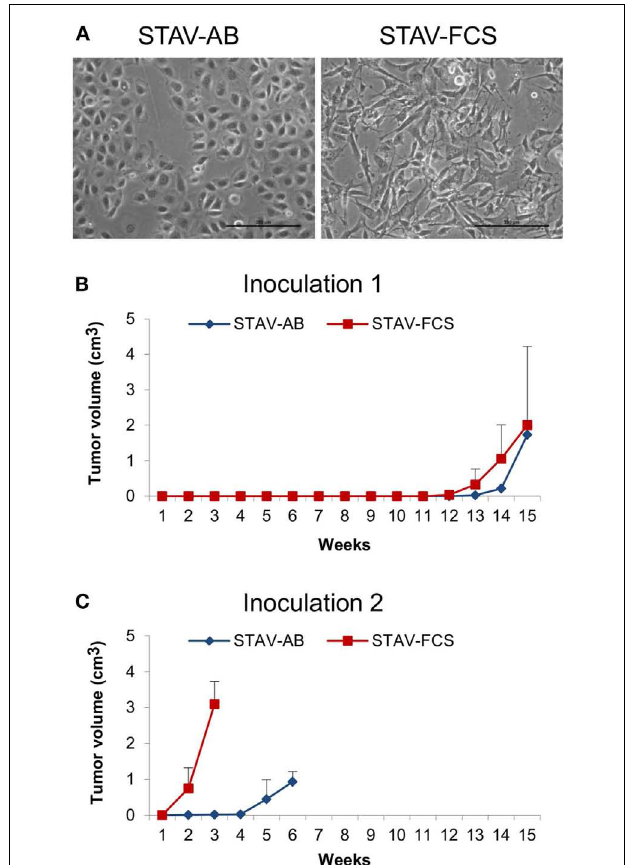
FIGURE 1 | Mesothelioma cells and xenografts . (A) Phase-contrast micrographs showing epithelioid cobblestone-like morphology in STAV-AB cells, and elongated fibroblast-like morphology in STAV-FCS cells. Scale bars are 200 µ m. (B,C) Tumor volume after inoculation of mesothelioma cells into SCID mice displaying epithelioid (STAV-AB) or sarcomatoid (STAV-FCS) phenotypes, respectively. After establishment, tumors were serially passed through a second set of